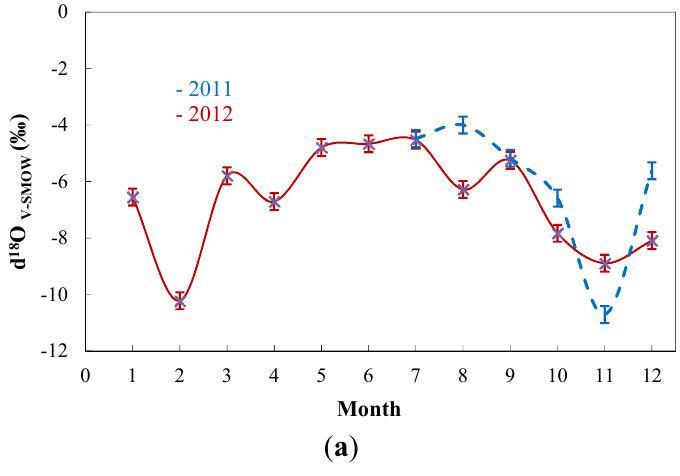
Figure 2. Monthly variation of ( a ) δ 18 O and ( b ) d-excess with error bars for the rainfall in 2011 (dotted line, no symbol) and 2012 (plain line, cross symbol) near